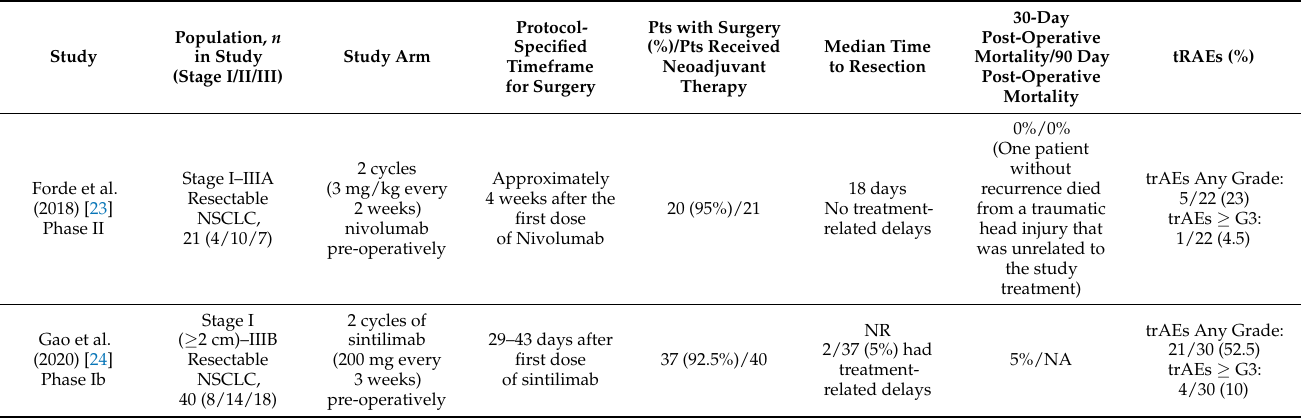
Table 2. Summary of Safety Outcomes from Neaodjuvant Single Agent Immunotherapy Trials with Reported